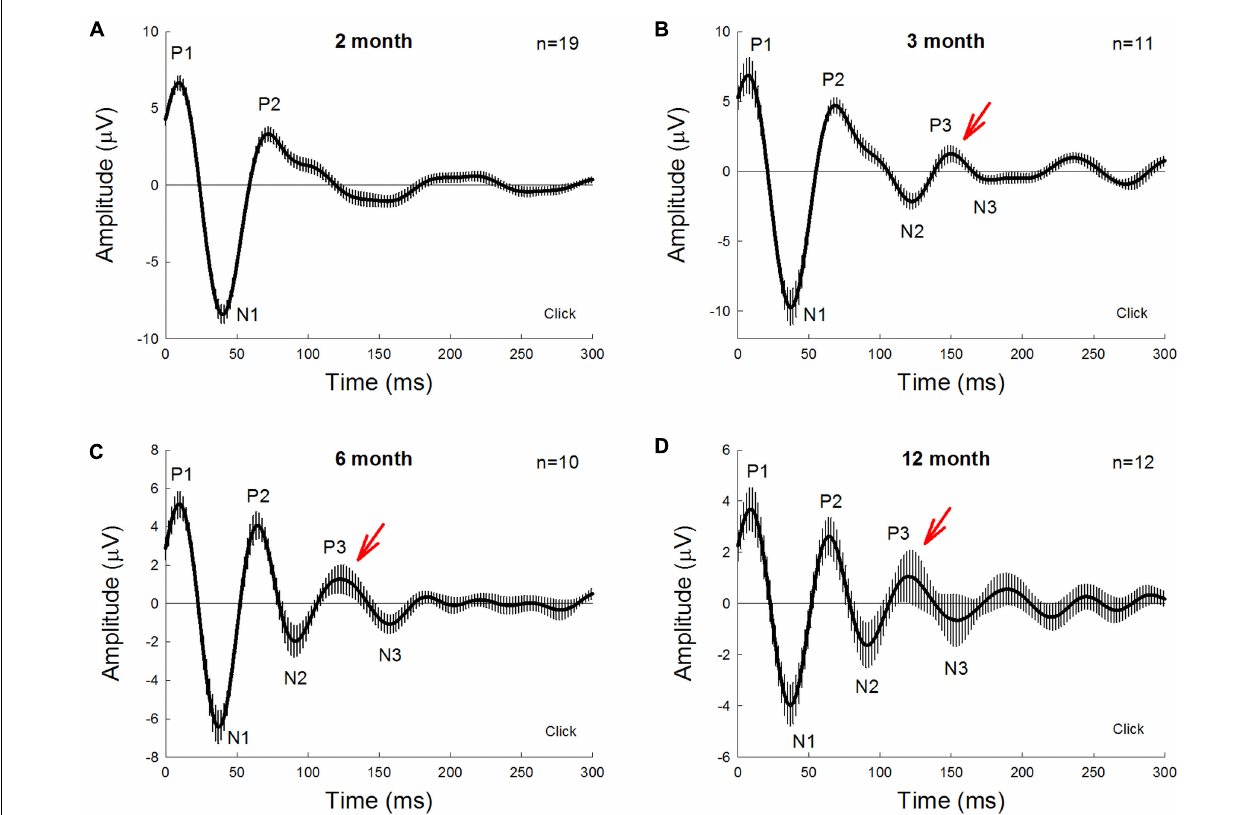
FIGURE 1 | Auditory-evoked cortex potential (AECP) in CBA/CaJ mice at different ages. AECP was evoked by a click stimulus (85 dB SPL) in alternative polarity. Traces were averaged from the recorded mice with both genders. Error bars represent SEM. Mouse age is indicated in each panel. N is the mouse number. AECP in mice has three positive peaks, i.e., P1, P2, and P3, and three corresponding negative N1, N2, and N3 peaks. Red arrows indicate P3 peak that is clearly visible in AECP at 3 months old and